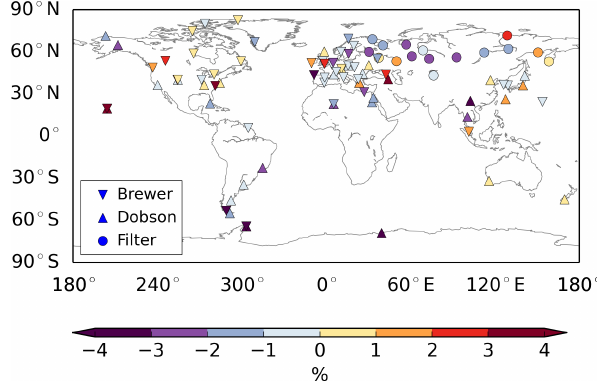
Figure 1. Mean total column ozone differences (%) between OMI- TOMS and Brewer, Dobson, and filter ozonometer measurements over July–August 2014. The colours blue to purple denote negative differences and the colours yellow to red refer to positive differ-